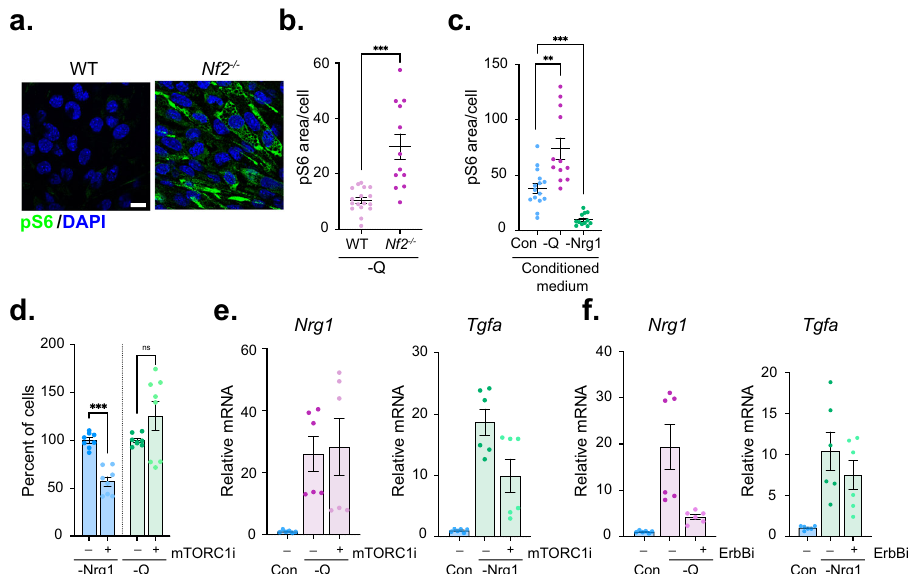
Fig.5|HeterogeneousmTORactivationanddrugsensitivity.a Confocalimages depicting the dramatic induction of pS6 (green) in glutamine-deprived Nf2 − / − SCs but not WT SCs. Scale bar, 10 µ m. b Quantitation of pS6 levels in cells in a as measured in thresholded confocal images as the ratio between pS6 area and total cellarea.Datapointsaregraphedfor n =12(WT)or n =17( Nf2 − / − )cellspercondition and lines represent mean±SEM. c Quantitation of pS6 levels in Nf2 − / − SCs treated with conditioned medium from glutamine- ( − Q) or Nrg1 − deprived Nf2 − / − SCs. Data points are shown for n =15 (Con.) or n =12 (-Q, -Nrg1) cellsper condition, and lines representmean±SEM. d Quantitationofcellviabilityof Nf2 − / − SCsdeprivedofNrg1 or glutamine upon treatment with mTORC1i (100nM, 72h). Bars represent mean±SEM percentage of cells compared to vehicle treatment for n =8 samples